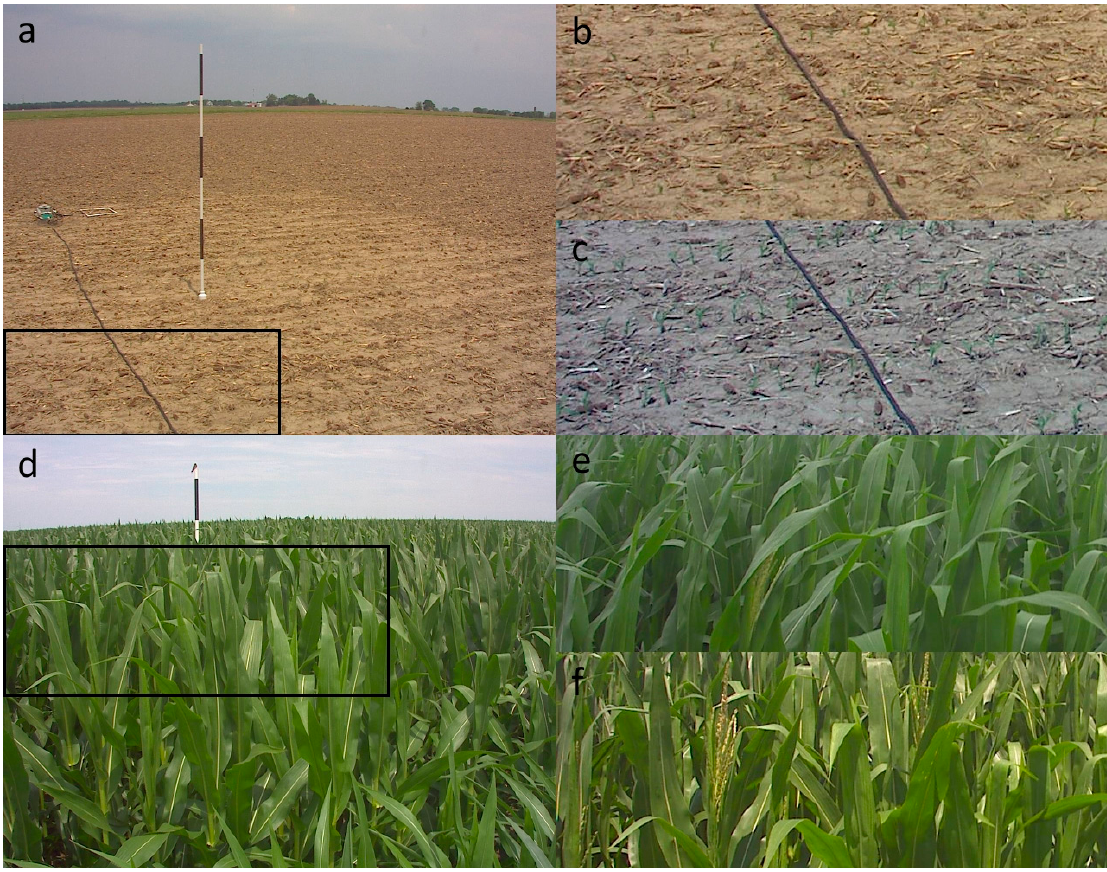
Figure 8. Midday images from the uiefmaize site in 2009; shown are ( a) the full landscape view before plant emergence, ( b,c ) the sub-region of ( a ) enlarged to see details of emergence, ( d ) the vegetated landscape view, and ( e,f ) the sub-region of ( d ) enlarged to show crop detail; ( a ) corn plants not visible, 23 May; ( b ) first day researchers can see corn plants, 24 May; ( c ) first day Season Spotter indicates corn plants, 29 May; ( d ) no corn tassels visible, 14 July; ( e ) first day researchers can see tassels, 15 July; ( f ) first day Season Spotter indicates tassels, 16 July.